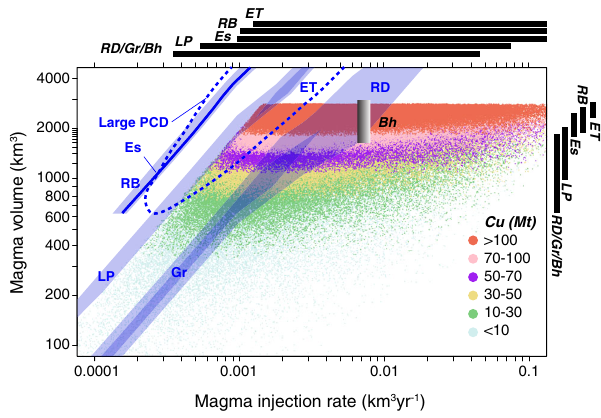
Fig. 5 Monte Carlo simulations of magma volumes versus injection rates. Monte Carlo simulations of magma volumes versus injection rates subdivided by color codes indicating different intervals of potential Cu endowments. The blue fi elds and associated blue labels correspond to individual porphyry copper deposits from combination of hydrothermal and magmatic activity ages of the deposits 16 , the fi eld enclosed by the blue dashed line is the fi eld of large porphyry copper deposits (PCD) based on zircon age distribution modelling 15 , and the Bingham Canyon (Bh) value is inferred from geochemical and thermal modelling of zircons 60 . The black bars (and associated black labels) correspond to the magma volumes and magma injection rate intervals constrained by the present study on the basis of Monte Carlo simulations for the same individual deposits of 16,60 . Es Escondida, ET El Teniente, Gr Grasberg, LP Los Pelambres, RB Rio Blanco, RD Reko